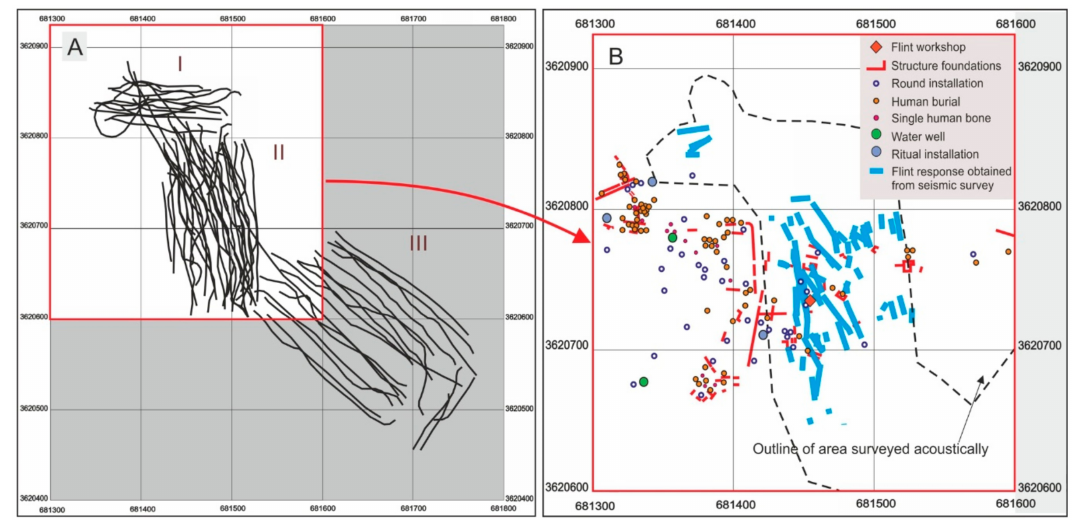
Figure 9. ( A ): The survey lines recorded at Atlit Yam. ( B ): The surveyed part of the settlement area is marked with the dashed black line. In the upper right corner is a key to the different types of settlement features recorded through excavation within the settlement area. The blue lines mark locations where haystacks were observed in the Chirp III profiles. Coordinates are in Universal Transverse Mercator (UTM, zone 36N). Settlement features are based on Galili & Rosen (2011) and the original chirp-III recordings from 2014 [41]. Graphics: